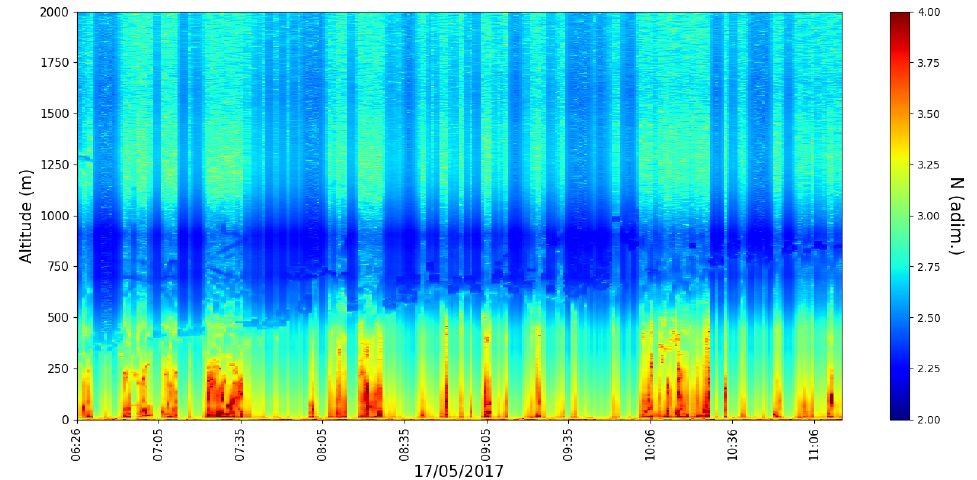
Figure 15. 𝑁 profile timeseries, profiling rate 1/min, 17 April 2017.